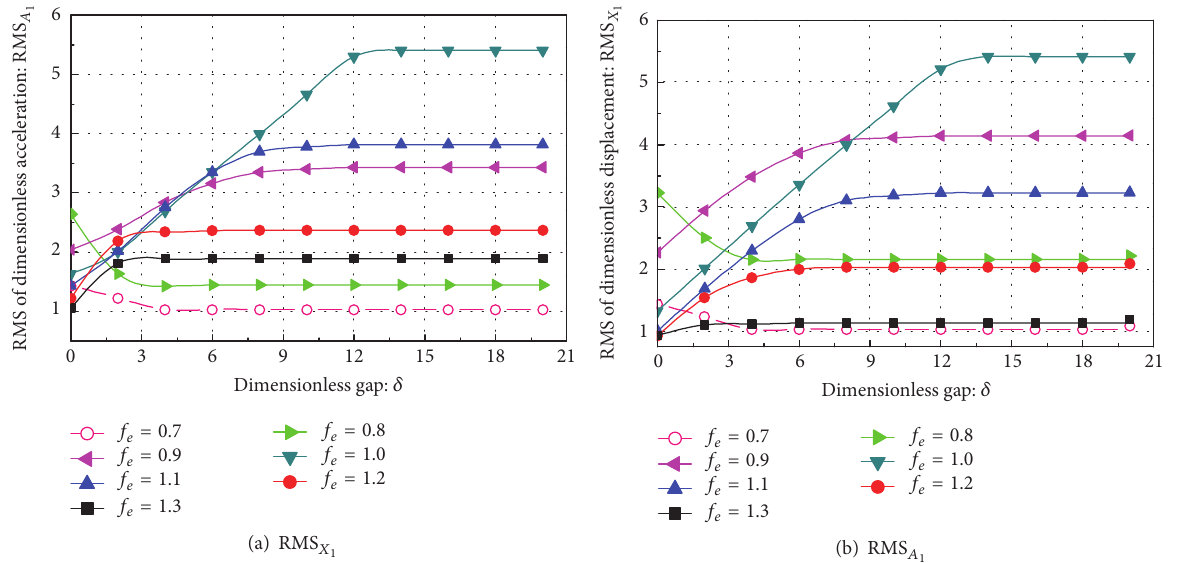
Figure 6: Primary structure RMS curve along with the change of 𝛿 ( 𝜉 2 = 3𝜉